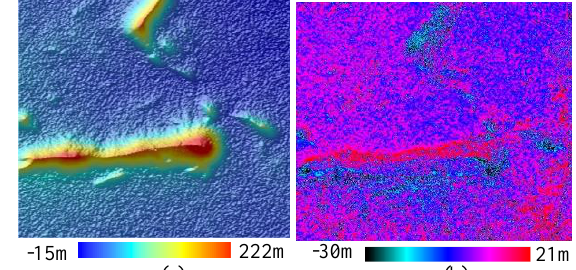
Figure 6. (a) TanDEM-X DEM of a small region from 29-01- 2012 data and (b) Difference between TanDEM-X and aerial photogrammetric DEM.